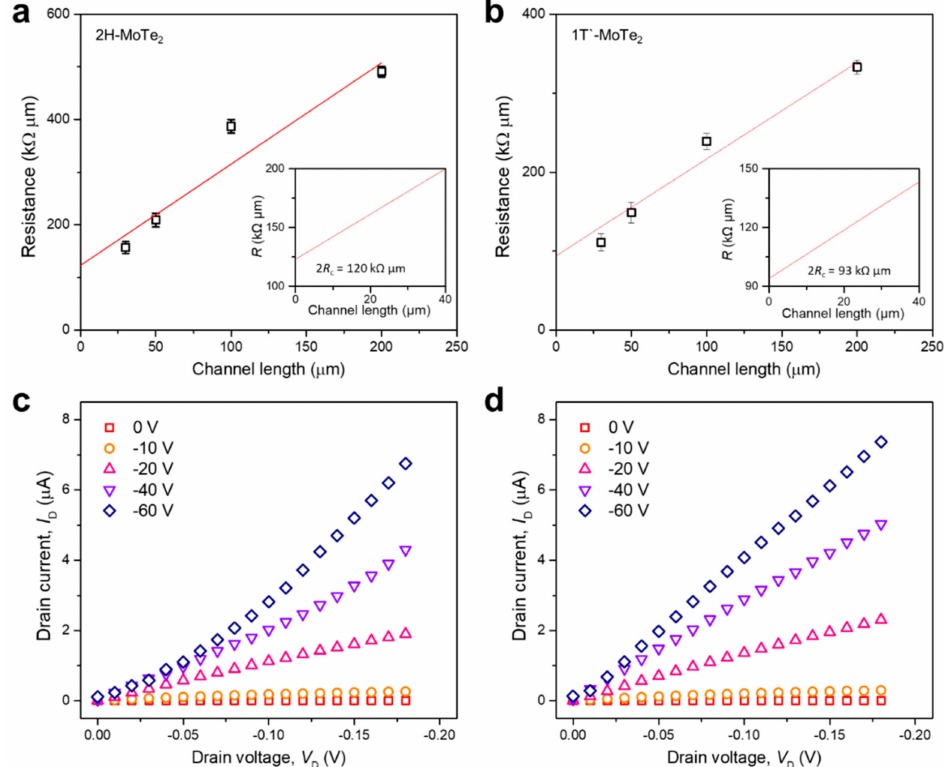
Figure 3. Contact resistance of the 2H-phase and 1T (cid:48) -phase of MoTe 2 FETs: ( a ) 2H MoTe 2 and ( b ) 1T (cid:48) MoTe 2 FETs after laser irradiation. The channel width is normalized using the resistance obtained from 2H MoTe 2 FETs; Output curves of ( c ) 2H and ( d ) 1T (cid:48) -phase MoTe 2 FETs after laser irradiation; the FETs have gate voltages ranging from 0 to − 60